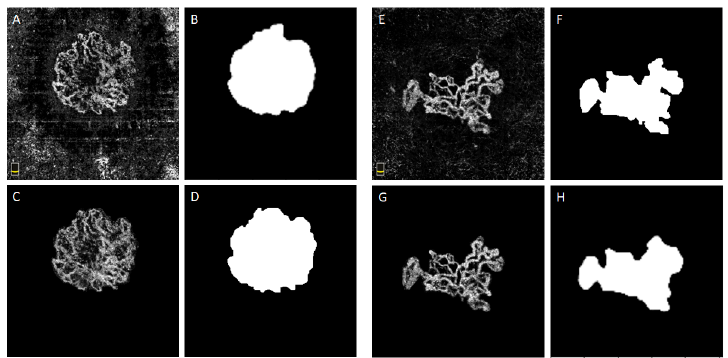
Figure 6. Examples of performance of SEG-CNV ( A , E ) in outer retinal en-face images. ( B , F ) Ground Truth, ( C , G ) Predicted CNV mask by SEG-CNV represented by the white pixel on black background, ( D , H ) CNV ROI by SEG-CNV as final output of this segmentation.